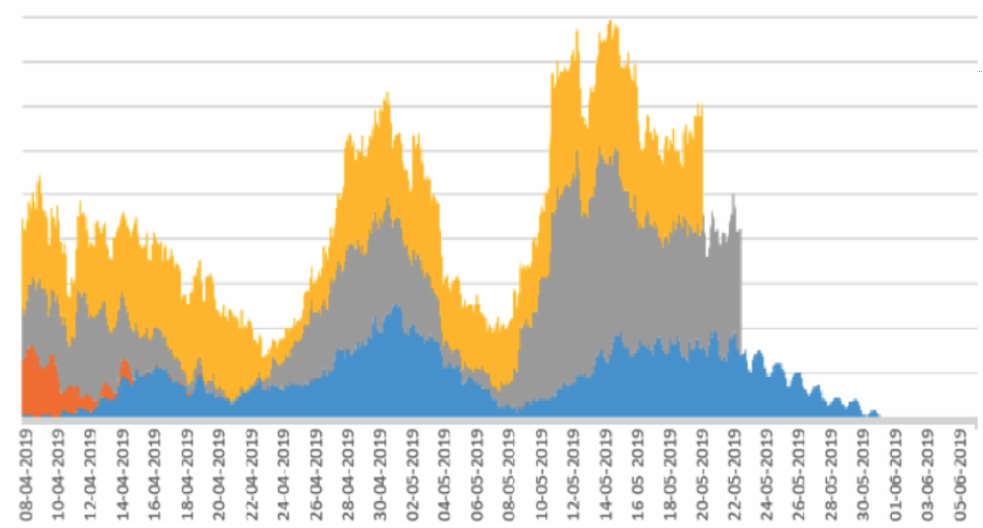
Figure 9. Stacked line graph for aligned periodicity intensities for calves 16–19. Each colour represents a different